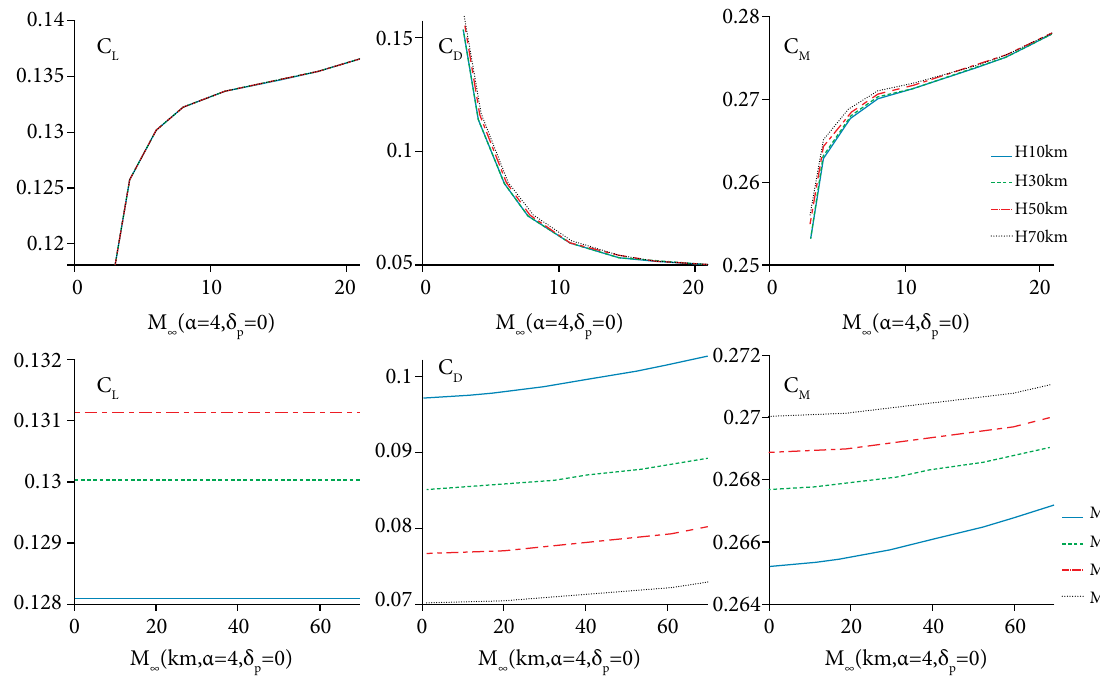
Figure 6. Relationship between aerodynamic coefficients and Mach number and